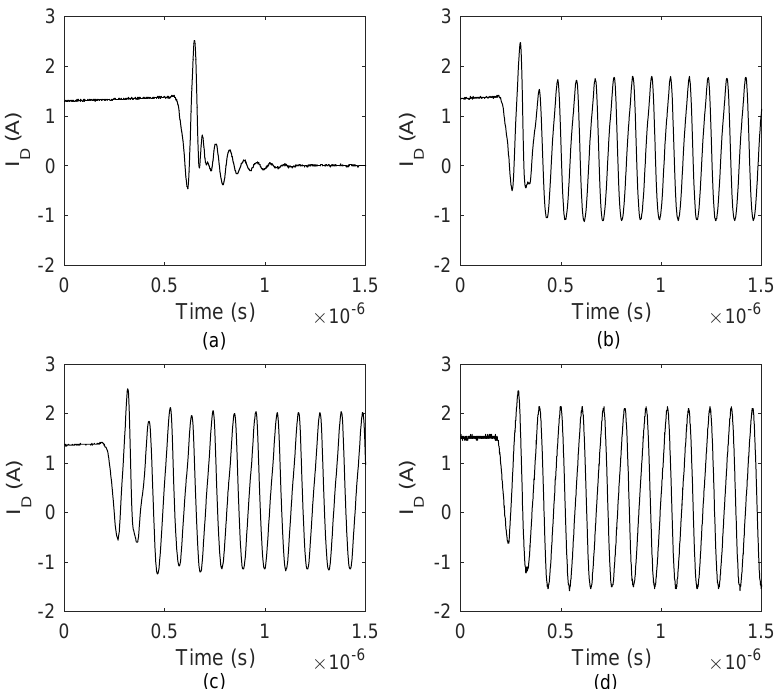
Figure 20. The experimental type II oscillation waveforms of the drain current I D with R G = 1.5 Ω . ( a ) L C = 200 nH and L G = 22 nH. ( b ) L C = 310 nH and L G = 22 nH. ( c ) L C = 460 nH and L G = 41 nH. ( d ) L C = 530 nH and L G = 22 nH.